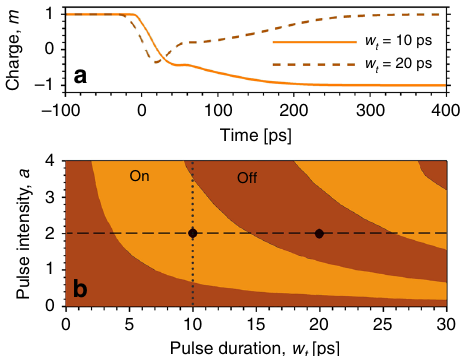
Fig. 4 Control pulse dependence and system dynamics. a Time evolution of the total topological charge of the polariton condensate for different duration of the control pulse with w t = 10 ps and w t = 20 ps, respectively, for fi xed intensity with a = 2. For w t = 10 ps successful vortex switching occurs whereas for w t = 20 ps the charge returns to its original + 1 state. b Computed fi nal switching state depending on pulse duration w t and pulse intensity a . Orange regions represent successful switching, leaving the system in the on state. For brown regions the system returns to the off state after the control pulse has passed. Parameter sets used in panel a are indicated as black dots in panel b